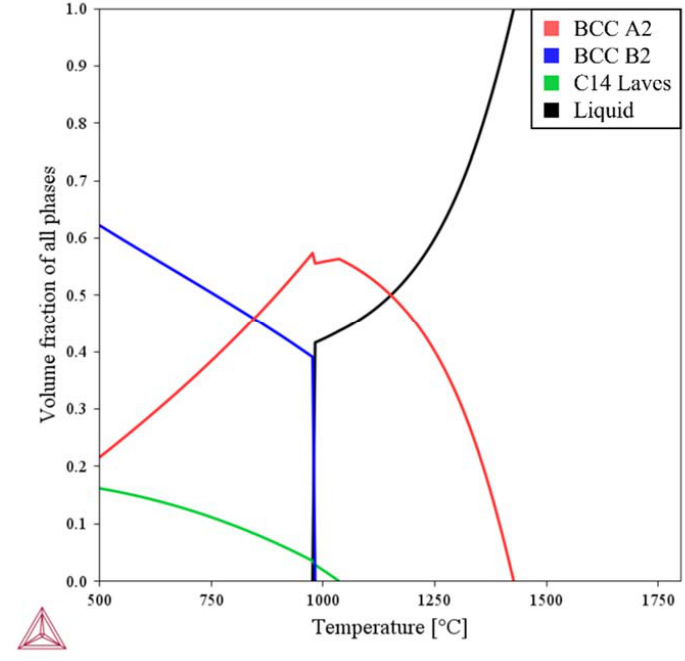
Figure 3. The phase fractions of Ti ‐ Nb ‐ Cr ‐ V ‐ Ni ‐ Al.